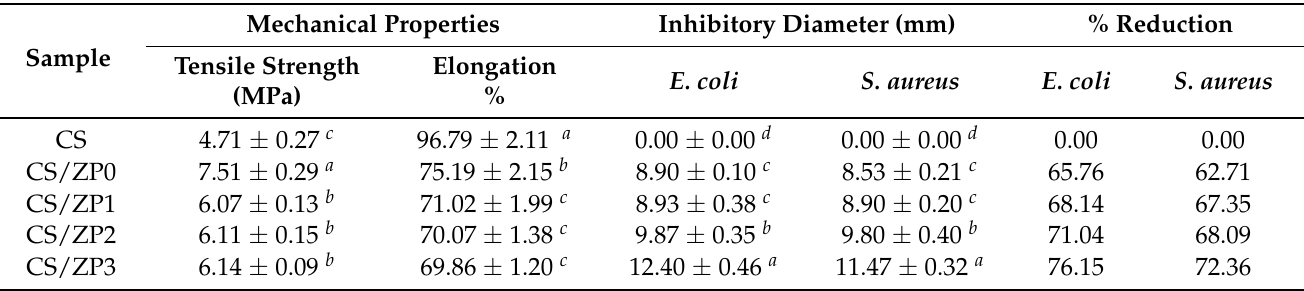
Table 3. Mechanical properties, diameters of inhibition zones, and antibacterial activity of CS film and bionanocomposite film samples against E. coli and S. aureus